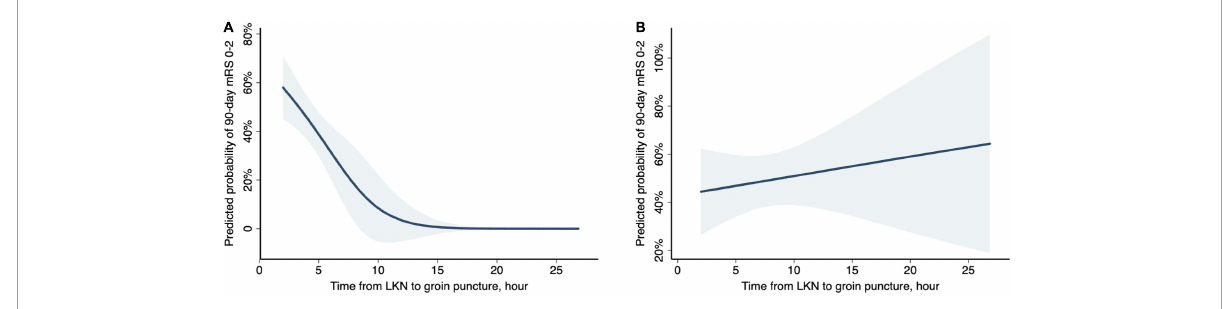
FIGURE1 Probability of functional independence (90-day mRS, 0–2) by time from last known normal (LKN) to groin puncture in stroke subtypes. Curves (blue shading indicates 95% CIs) represent the predicted probabilities of functional independence under logistic regression models. (A) In CE-related strokes, after adjustment for age, baseline NIHSS, diabetes, and any ICH, there was a 47% decreased probability of functional independence per hour treatment delay (aOR, 0.53; 95% CI, 0.32–0.88; P = 0.013). (B) In LAA-related strokes, after adjustment for age, baseline NIHSS, and any ICH, the association between LKN to puncture time and functional independence did not reach a statistical significance (aOR, 1.05; 95% CI, 0.91–1.21; P =